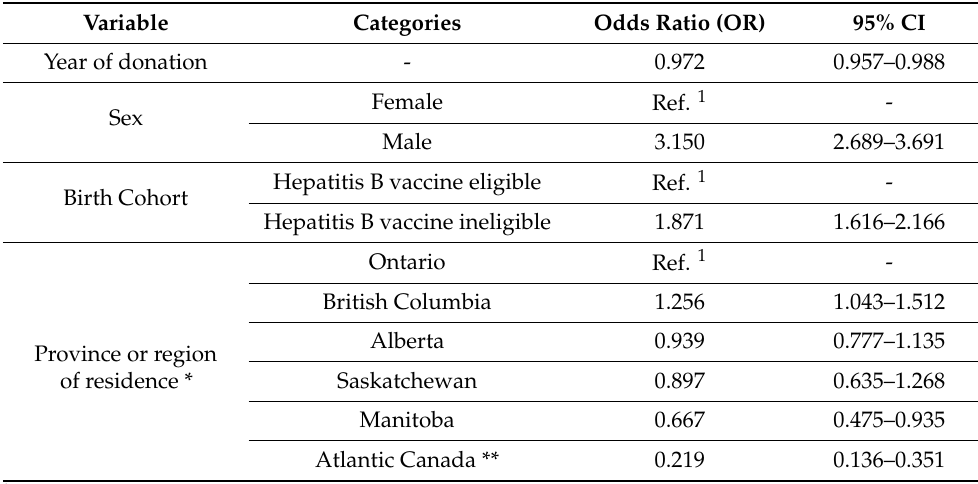
Figure 2. HBV clinical scenarios 1/3 (likely resolved/occult infection) rate (per 100,000 first-time donors) (95% confidence intervals) by vaccine age eligibility based on provincial routine programs from 2005–2020. Table 6. Output from multivariable logistic regression model, with clinical scenario 2 (likely chronic infection) as the dependent